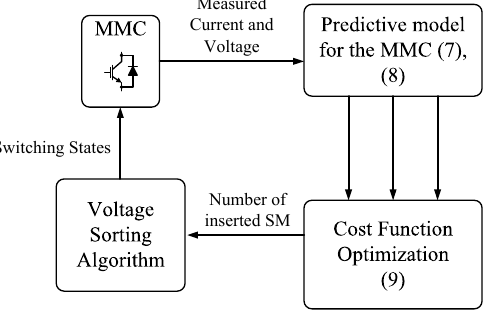
Figure 2. Indirect model predictive control scheme for MMC.